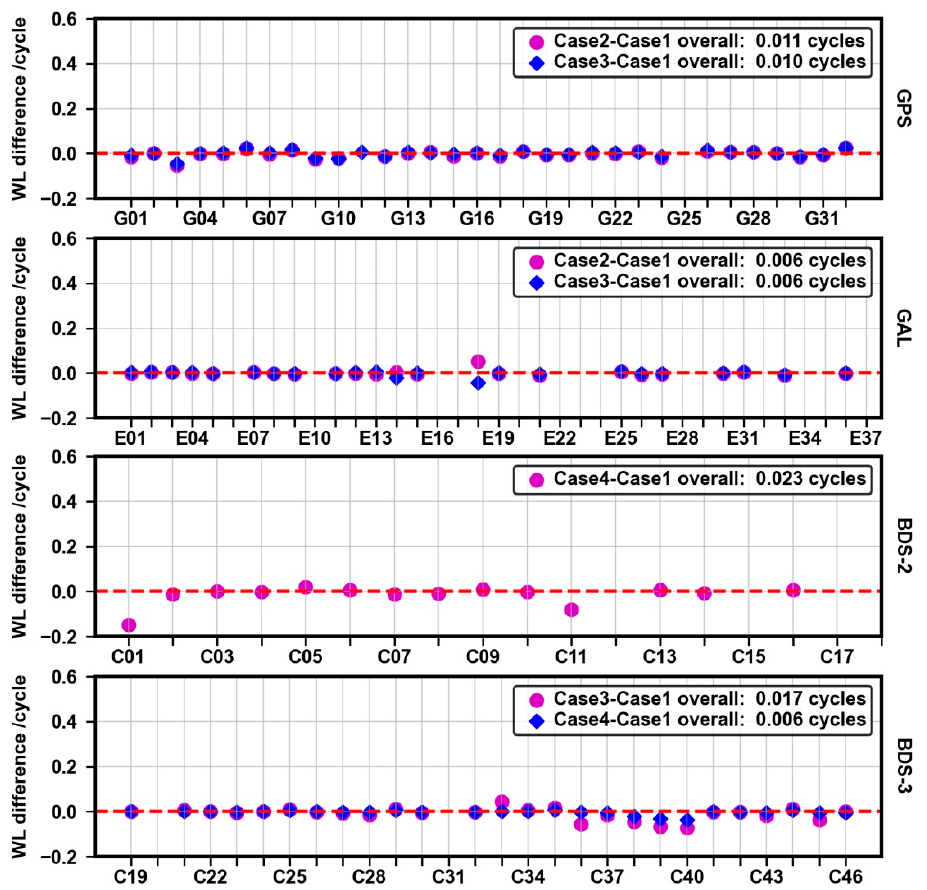
Figure 7. WL phase bias differences of different network strategies relative to Case 1 with the cali ‐ bration.